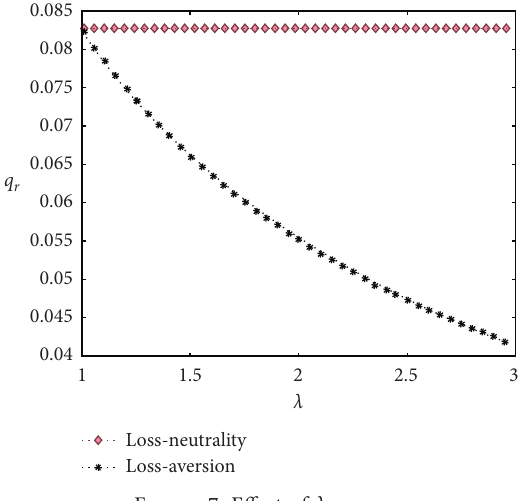
Figure 7: Effect of λ on q